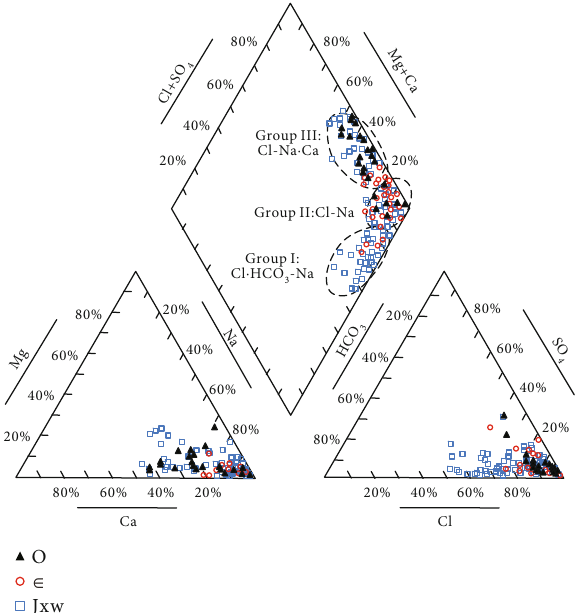
Figure 6: Piper diagram of geothermal water in the buried hill of the study